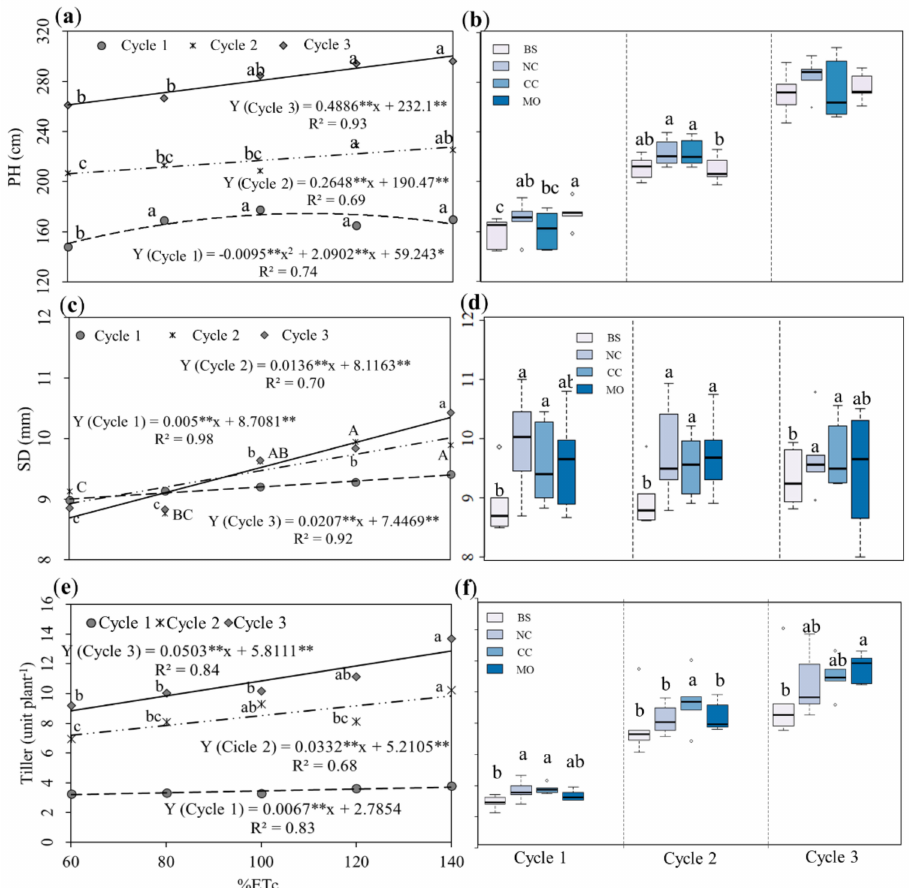
Figure 4. Behavior of sorghum plant height (PH), stem diameter (SD), and number of tillers (NT) as a function of irrigation depths with wastewater ( a , c , e ). Box plots for PH, SD, NT under different soil cover conditions ( b , d , f ), for cycles 1, 2, and 3 of sorghum. Averages were compared using Tukey’s test ( p < 0.05) and are indicated by lowercase letters. The significant regression coefficients are for p < 0.01 (**) and p < 0.05